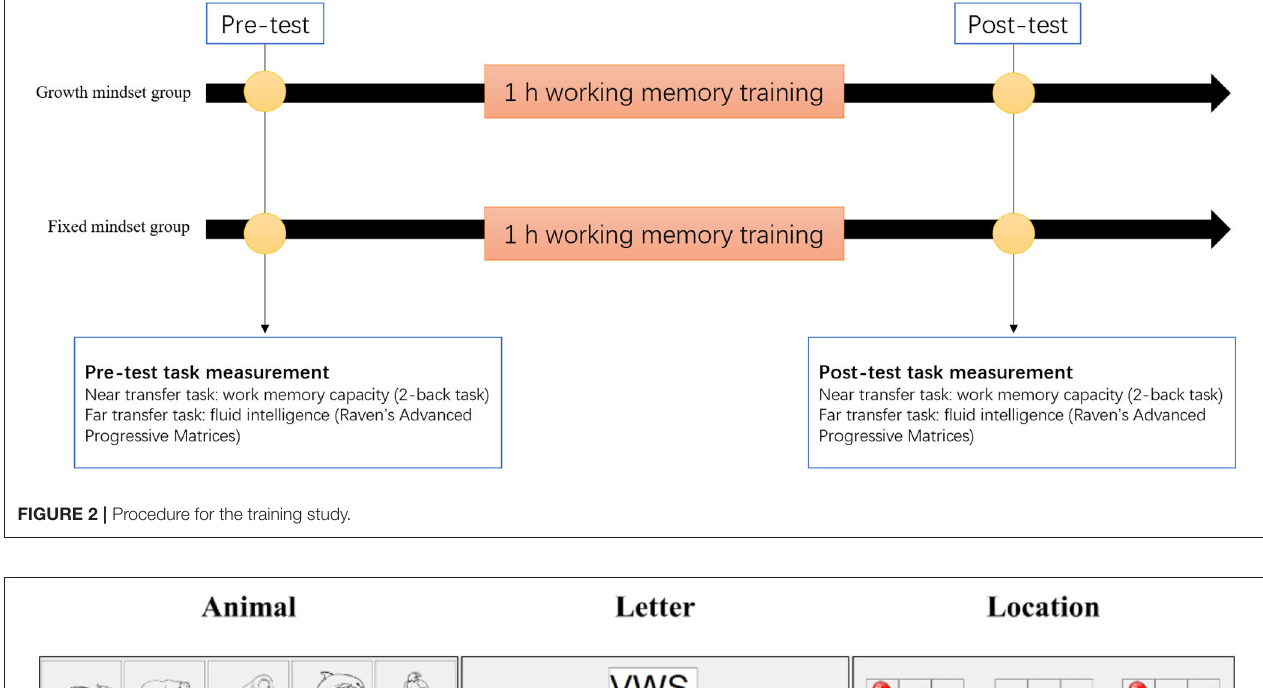
FIGURE 2 | Procedure for the training study.